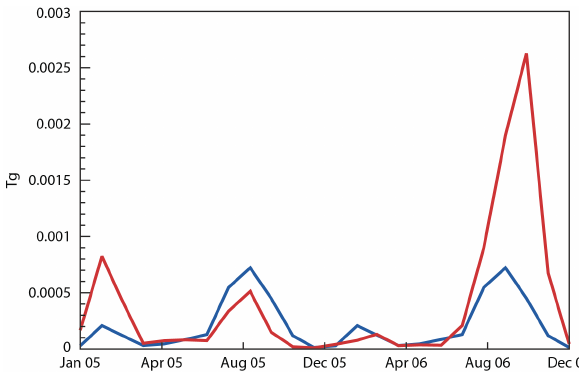
Figure 13. Time series of CO biomass burning emissions in Tg av- eraged over the region 10 ◦ N–10 ◦ S, 90 ◦ E–130 ◦ E from GFAS v1.0 (red) and climatological GFAS v1.0 data set